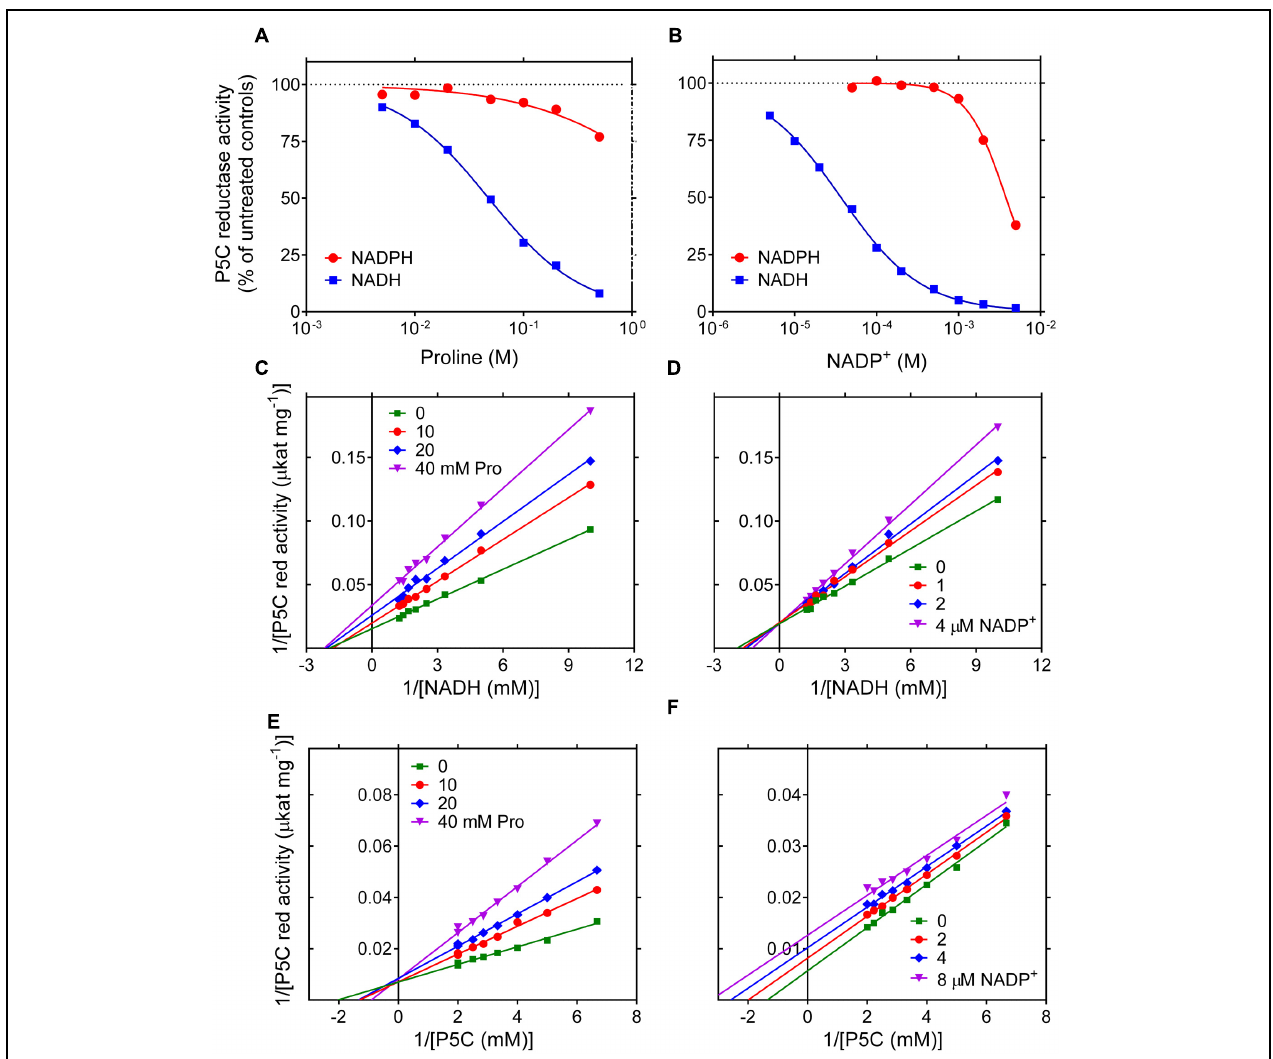
FIGURE 2 | Product inhibition of rice P5C reductase. The effect of increasing concentrations of proline (A) and NADP + (B) on the activity of the enzyme was determined using either NADH or NADPH as the electron donor. Results were expressed as percent of the activity in the absence of supplements, and are mean ± SE over three replicates. Non-linear regression analysis allowed the calculation of IC 50 values, which in the case of the NADH-dependent reaction were 47.7 ± 1.6 mM and 36.7 ± 1.1 μ M for proline and NADP + , respectively. The NADPH-dependent activity was much less sensitive to proline and NADP + , with estimated IC 50 values of 3.44 ± 1.51 M and 3.78 ± 0.12 mM, respectively. To investigate the mechanisms of product